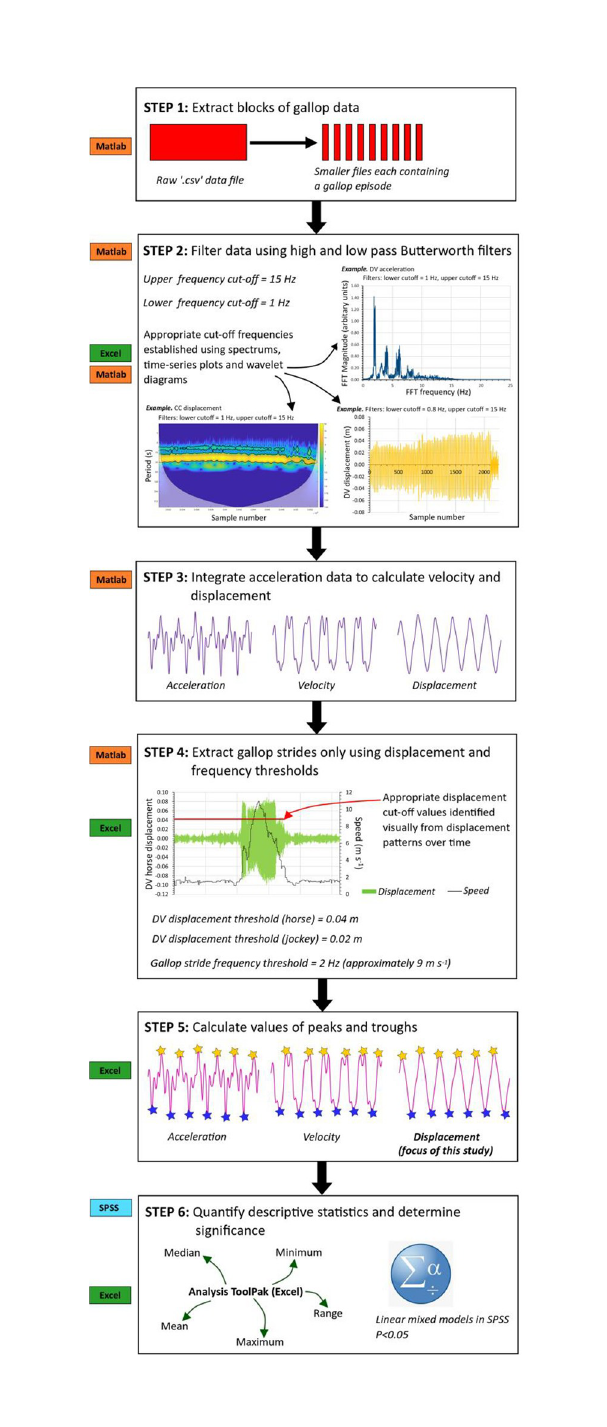
Fig 3. Data analysis flowchart showing the step-by-step method used to quantify centre of mass displacement patterns for horse and jockey. CC = cranio-caudal, DV = dorso-ventral.